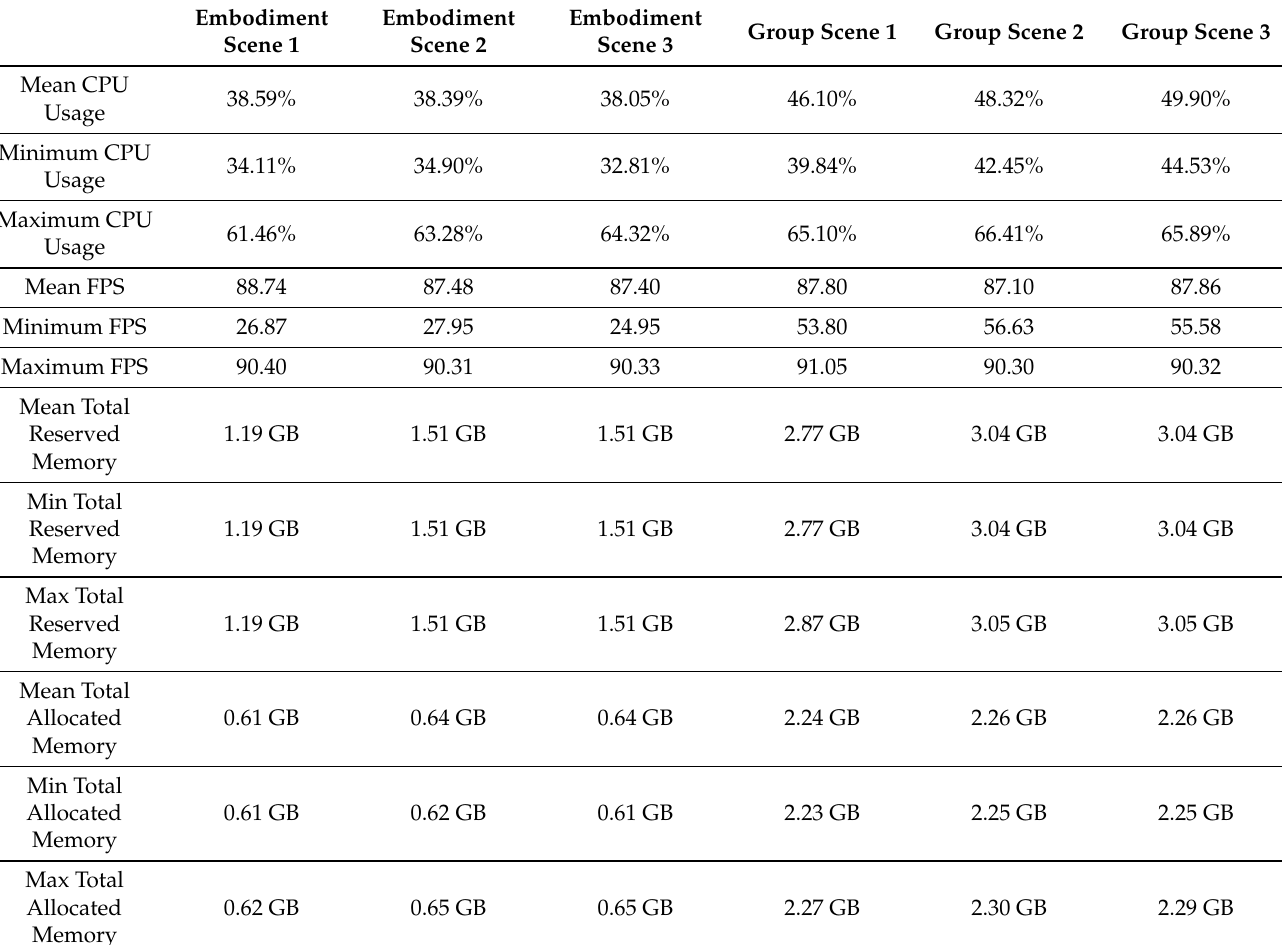
Table A1. Results for Test Condition 1: no ManySense VR. The columns show the results for each